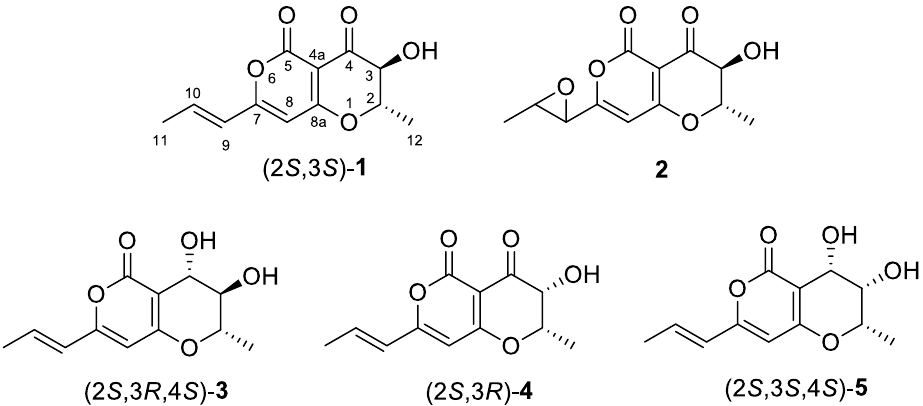
Figure 1. Structure and assigned absolute configuration of radicinin ( 1 ) and of its structural analogue cochliotoxin ( 2 ) and of radicinol ( 3 ), 3- epi -radicinin ( 4 ), and 3- ep i-radicinol ( 5 ). Compounds 1 and 2 are treated in the text, while the chiroptical data of compounds 3 – 5 are treated in the Supplementary Material.